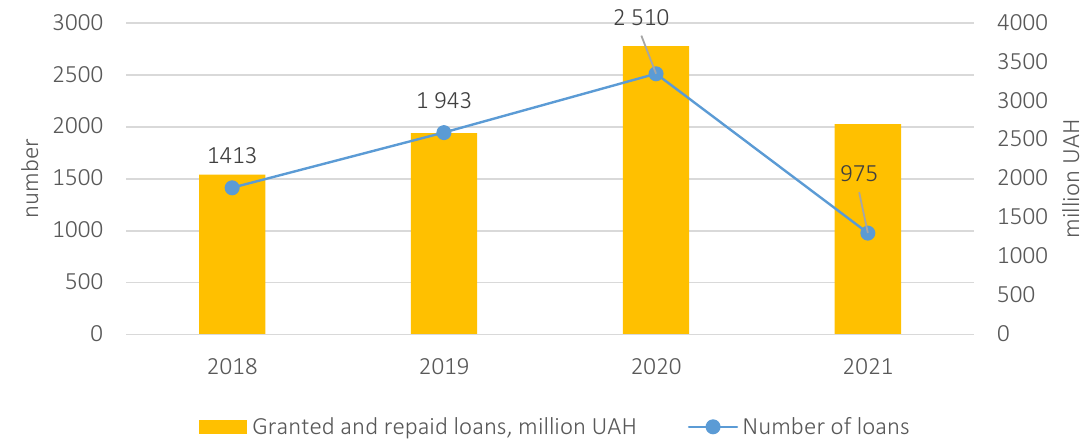
Figure 3. Loans to cover temporary gaps in local budgets of Ukraine from TSA funds, million